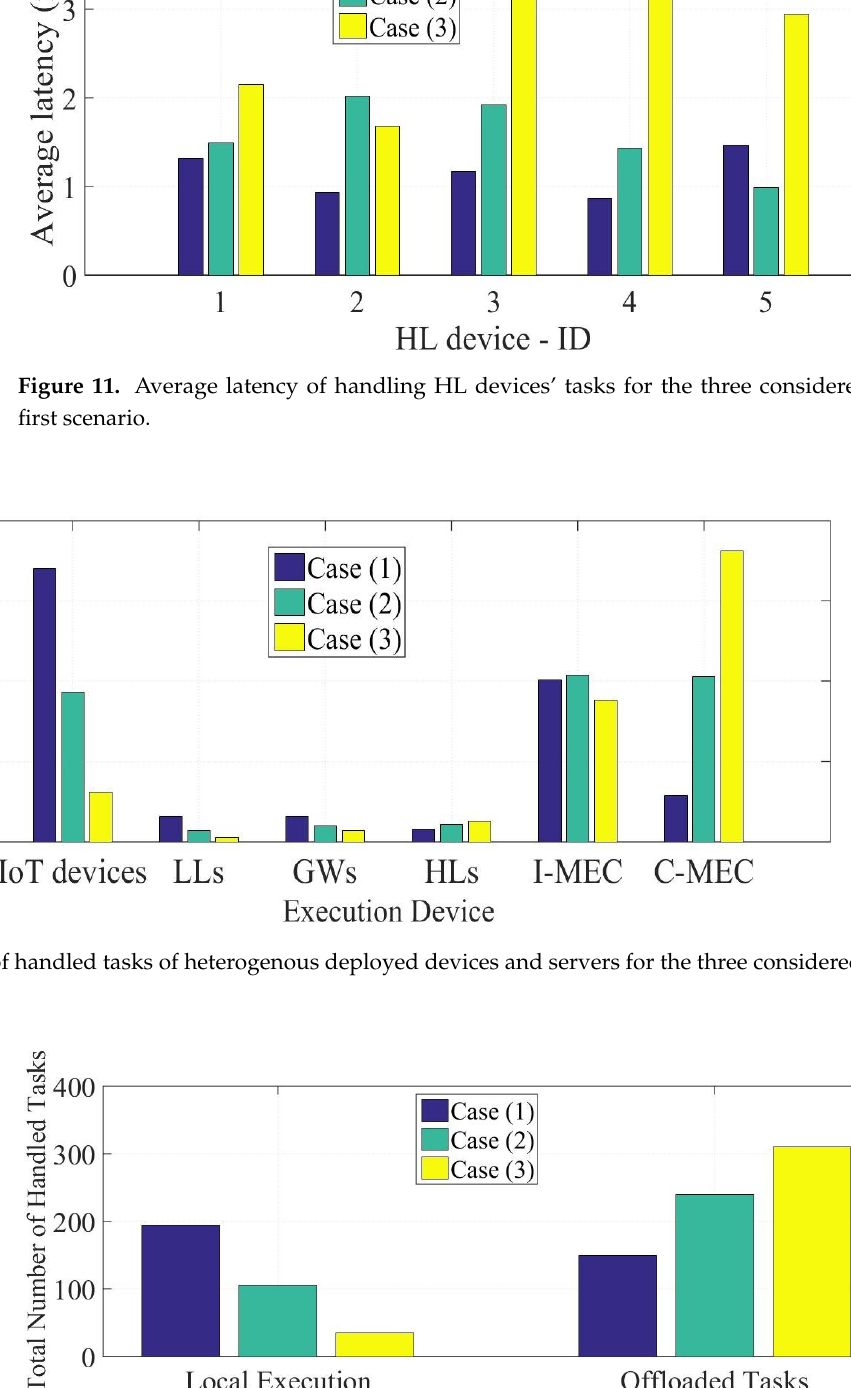
0 Table 10. Percentage of average remaining energy of IoT networks, after task execution, in case (II) of the second scenario.